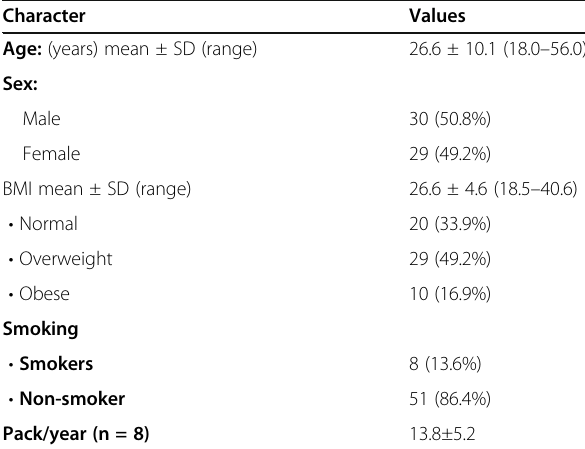
Table 1 Demographic data of the studied group